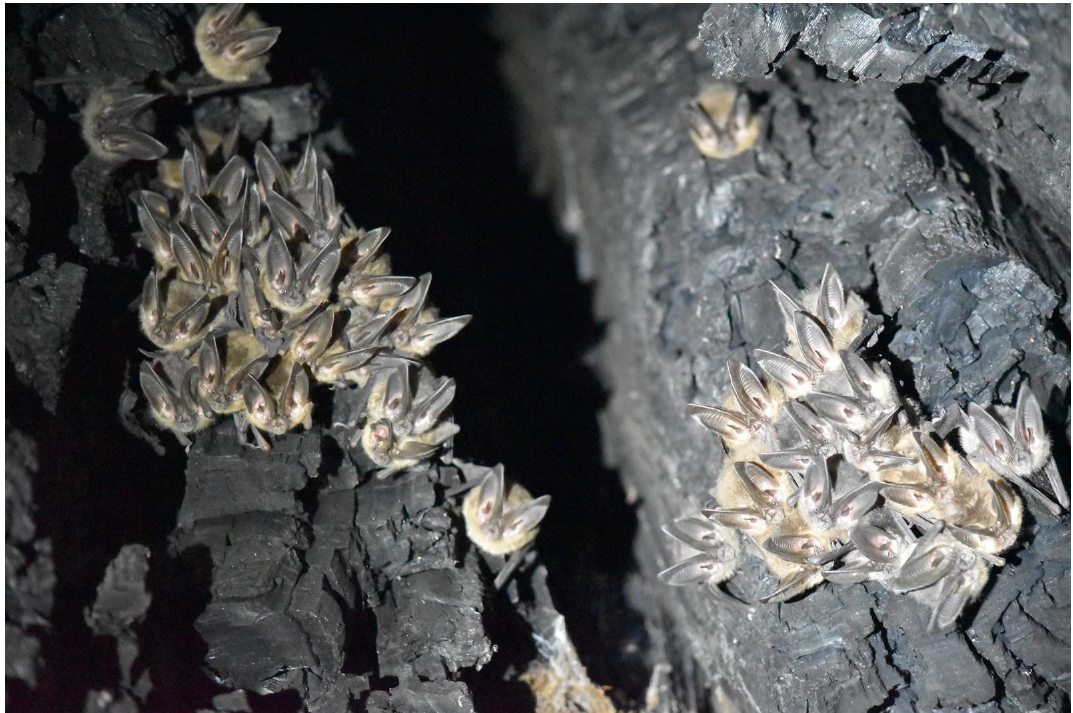
Figure 3. A maternal colony of approximately 40 Corynorhinus townsendii on 31 August 2017 in hollow 18 at Grizzly Creek State Park, Humboldt County, California. Photograph: A. Armstrong.